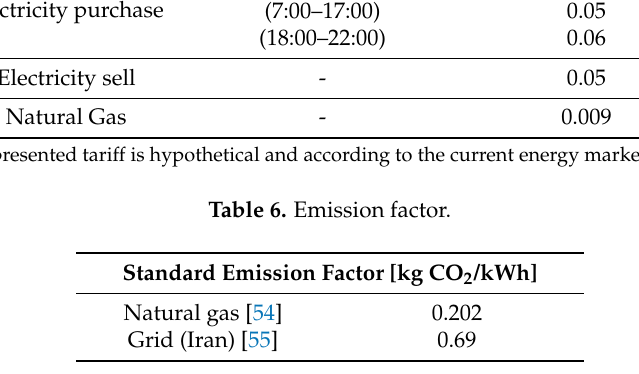
Table 7. Optimization search space